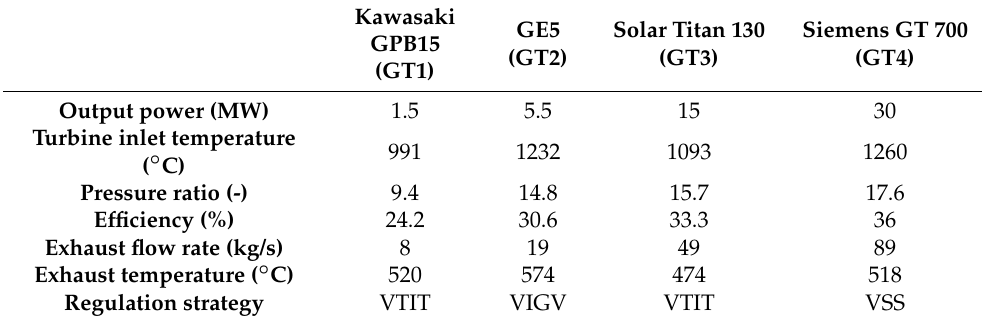
Table 1. Selected gas turbines nominal